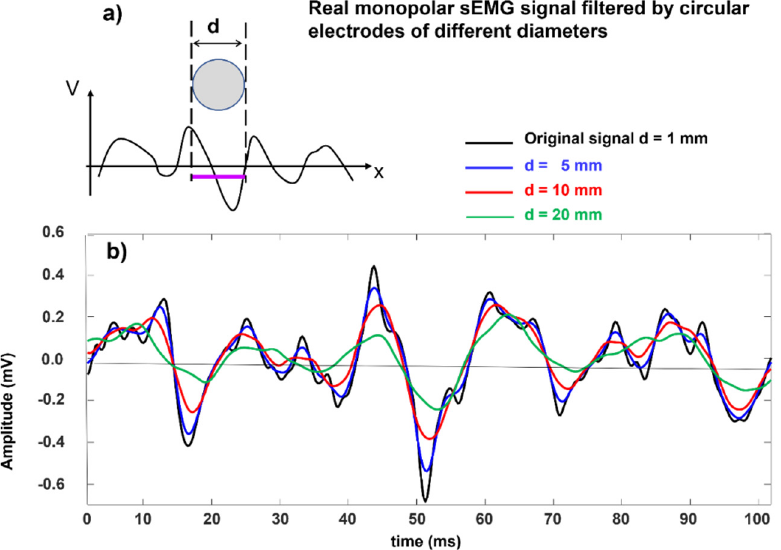
Figure 19. Electrode filtering of a monopolar experimental sEMG signal. ( a ) moving average performed by a round electrode over a propagating monodimensional signal, ( b ) a signal collected using a pin electrode is filtered by the transfer function of electrodes of different sizes (in one dimension only), producing a number of outputs that correspond to different electrode diameters. The signal is low-pass filtered and attenuated because only the filtering effect of the different electrode sizes are accounted for. In practice, a larger electrode covers more fibers, so the amplitude may not be reduced (it may actually increase) but the spectral alteration due to filtering remains and alters the amplitude and spectral features of the signal. Modified from https://www.robertomerletti.it/en/